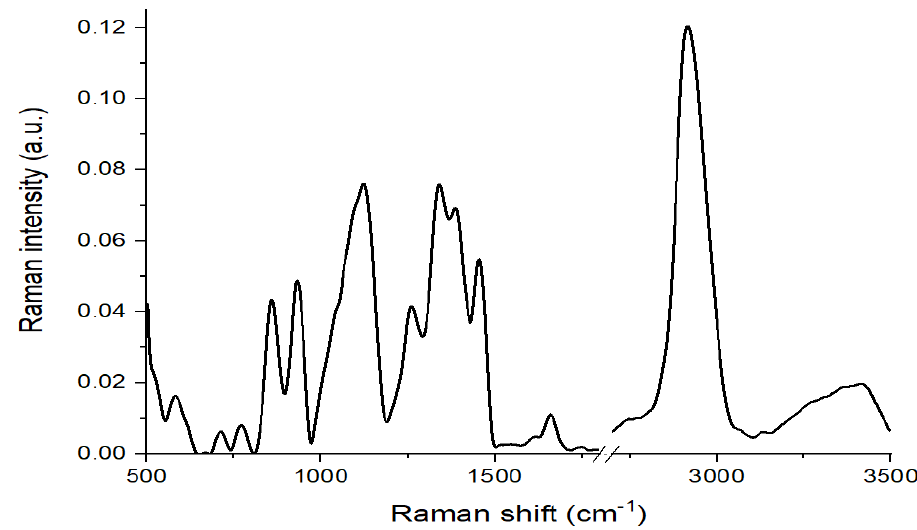
Figure 5. FT–Raman spectrum of control oat grains (seeds).